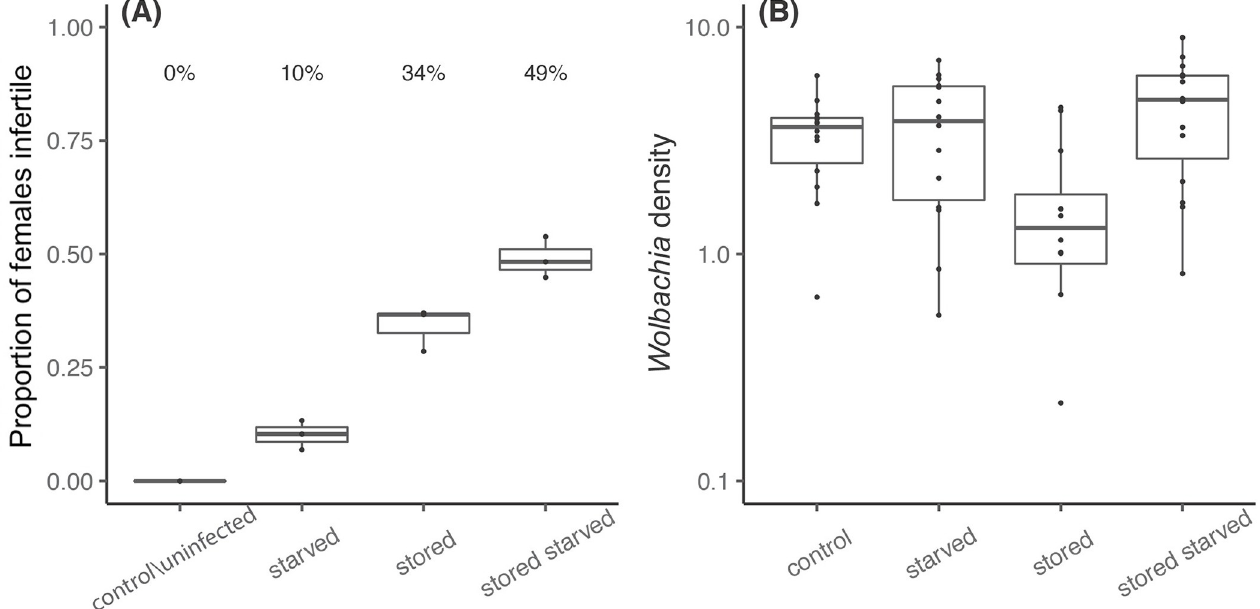
Fig 2. (A) Boxplots showing the proportion of infertile females in w AlbB-infected and uninfected mosquitoes with an egg stage that had lasted for 12 weeks (stored) or one week and a larvae stage that had been deprived of food for two weeks (starved) or that had not been deprived of food. Mosquitoes that had not been treated with “stored” or “starved” are designatedas “control”. No uninfected females from all four treatments were infertile. Values above boxplots represent corresponding averaged percentages based on two replicatesfor controls and three replicates for treatments with each replicate containing 30 individuals. (B) Boxplots of relative Wolbachia density in 3–5 days post-emergence females with unknown fertility status. Each group is based on two consistent real-time PCR